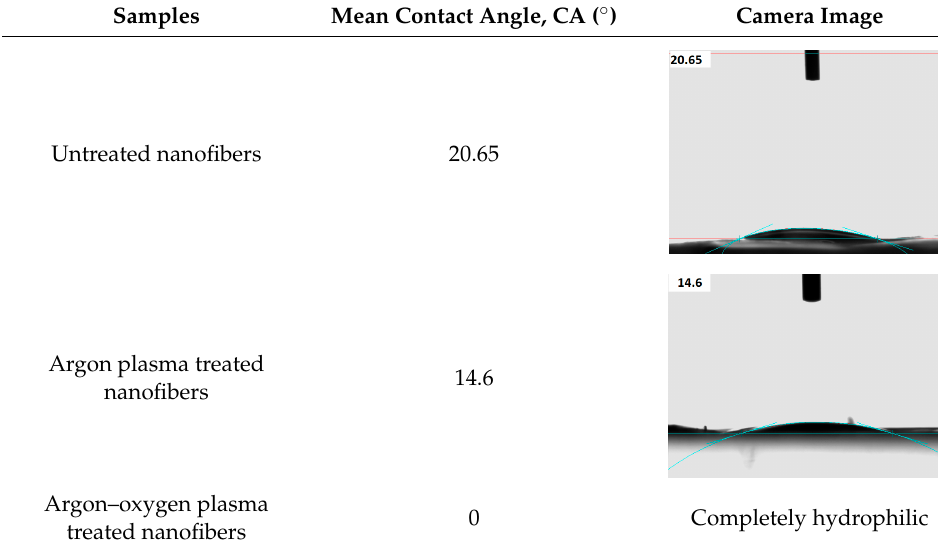
Table 3. Water contact angle of ( a ) crosslinked gelatin nanofibers scaffolds before plasma treatment, ( b ) nanofibers after argon plasma treatment and ( c ) nanofibers after argon–oxygen plasma treatment. Samples